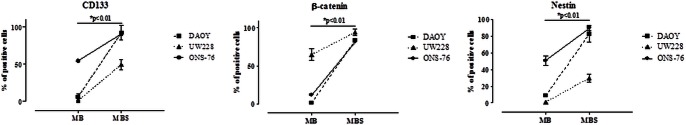
Analysis of MB and MDB expression by Flow cytometry.FACS analyses shows expression of progenitor markers, CD133 (A) beta- catenin (B) and nestin (C), evaluated in both MB and in MBS for all cell lines by flow cytometry. Graphs represent pooled data from three independent determinations. Standard deviations and Student’s T-test were calculate to compare MB and MBS. Probability values less than 0.01 were considered significant.